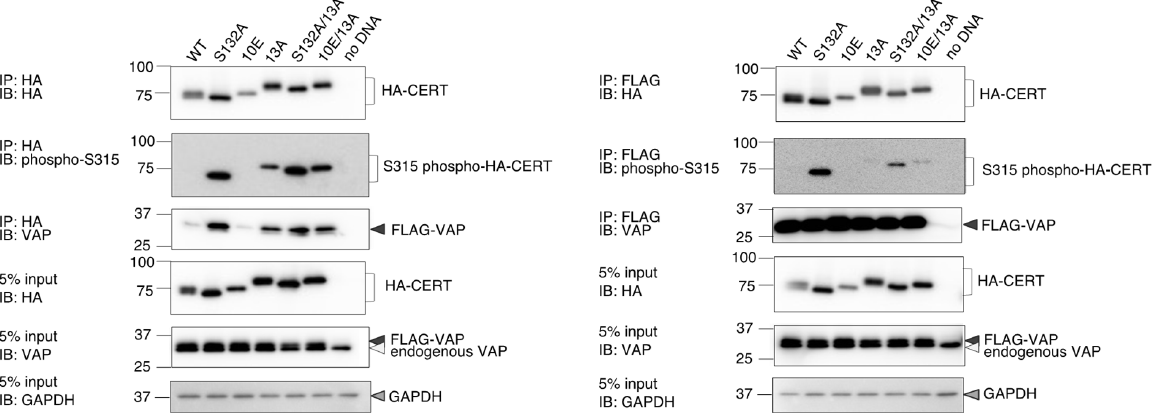
Figure 4. The 13A mutation enhances phosphorylation at the serine 315 and affinity of CERT for VAP. Various constructs of HA-CERT (WT, S132A, 10E, S132A/13A, and 10E/13A) and FLAG-VAP-A were transiently expressed in HeLa CERT KO cells, cross-linked, lysed, and co-immunoprecipitated (IP) using anti-HA antibody- or anti-FLAG M2-conjugated agarose gel. The immunoprecipitate and the 5% input samples were separated using SDS-PAGE and immunoblotted with anti-HA, anti-VAP-A, anti-phospho-serine 315, and anti-GAPDH antibodies. 2.4. The 13A Mutation Restores PtdIns(4)P-Binding and Ceramide-Transfer Activities in CERT 10E The PtdIns(4)P-binding activity and intermembrane ceramide-transfer activity of